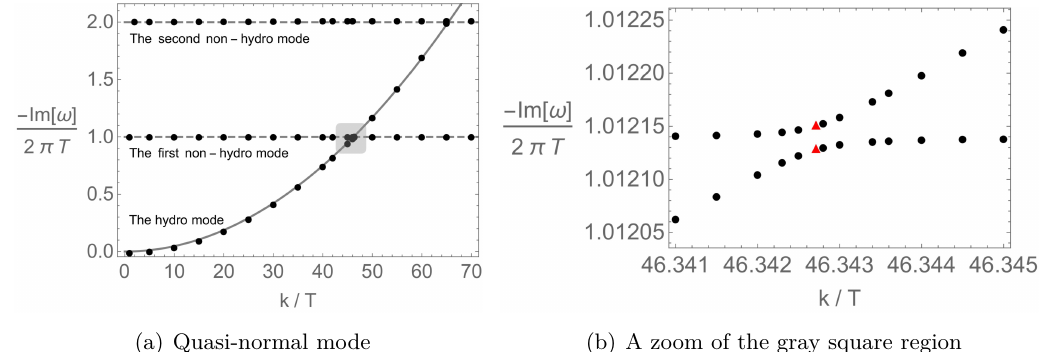
Figure 2 . Quasi-normal modes (black dots) at H/T 2 = 10 5 . Left: the solid line is the hydrody- namic mode (2.9) and the dashed line is the non-hydrodynamic mode (3.14). Right: a zoomed in figure of the gray square region in figure